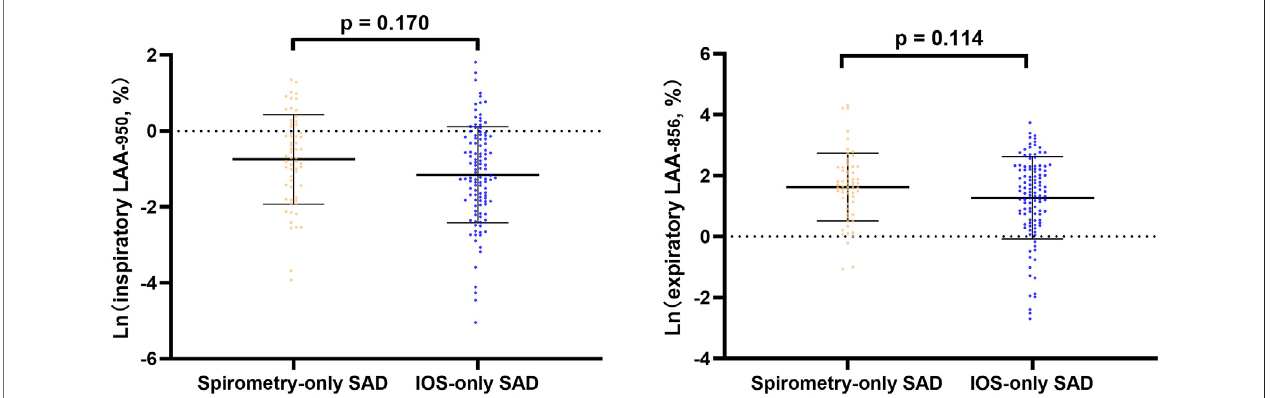
FIGURE3| LineregressionanalysisofCT-emphysemaand gastrapping difference between IOS-SAD and spirometry-SADin normal lungfunctionsubjects.After adjustingforbaselinestatisticaldifferencevariables(age,sex,BMI,smokingstatus,smokingindex,cough,phlegm, treatment,andfamilyhistoryofrespiratorydisorder). Ln: natural log. 61 spirometry-SAD subjects underwent CT and 113 spirometry-SAD subjects underwent CT in normal lung function subjects. Abbreviations: IOS, impulse oscillometry; SAD, small airway dysfunction; CT, computer